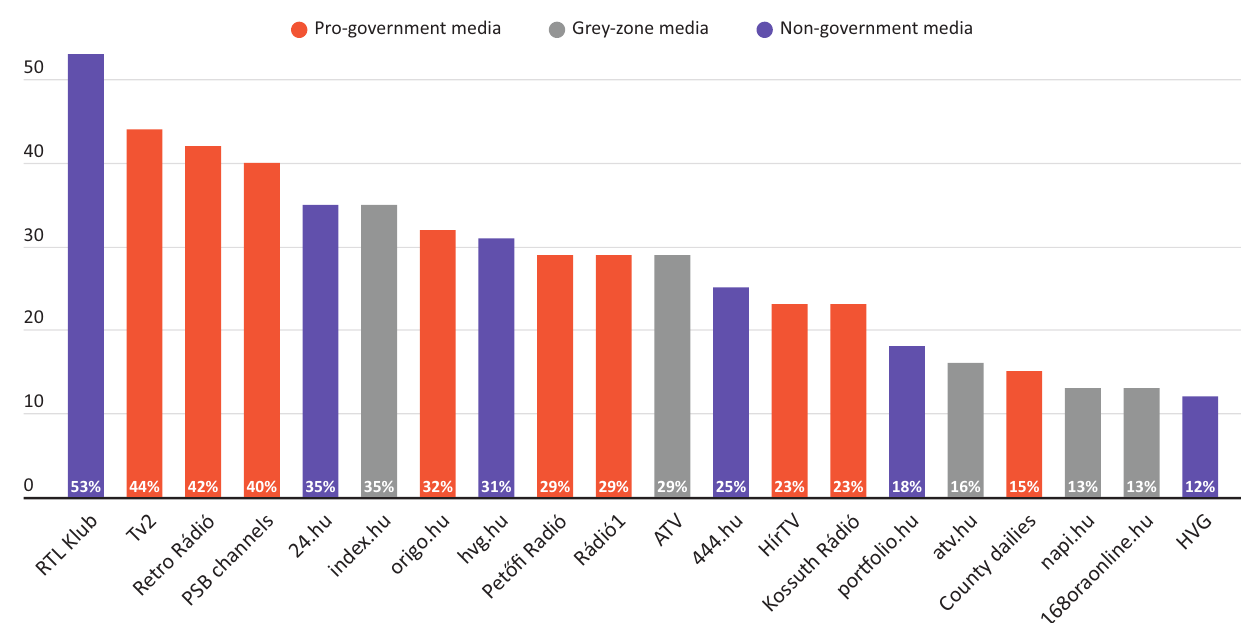
Figure 1. Percentage of regular consumers of the top 20 most regularly consumed media in the total sample (N =